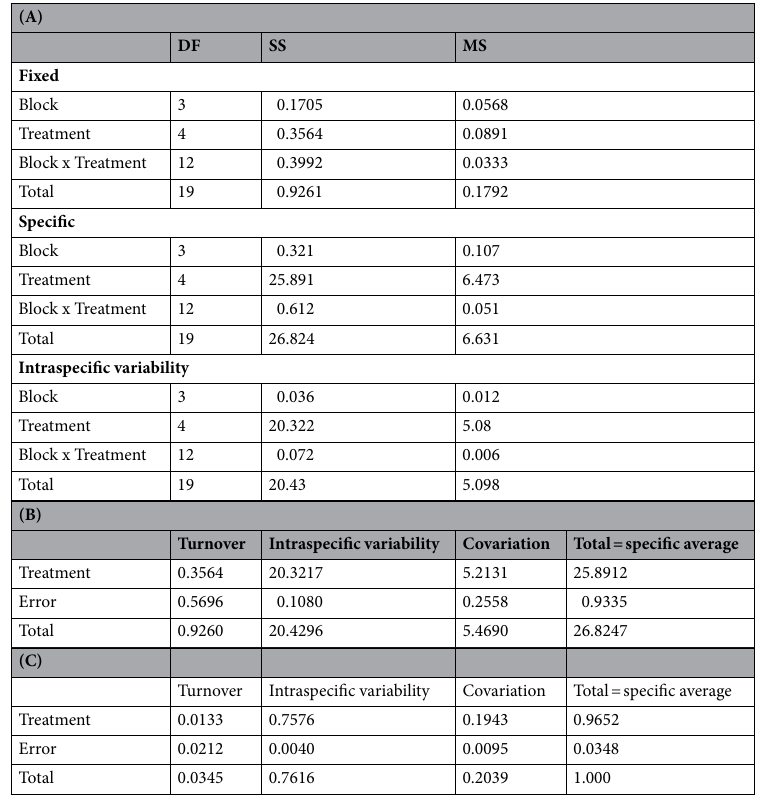
Table 3. Summary tables of the decomposition of total variability in plant height. (A) Fixed averages, specific averages and intraspecific variability effect analyzed separately. (B) Variability of individual component of height variation, and their parts explained by experimental treatments. Covariation is obtained by subtracting the first two columns from the last. C) Proportions of variability of individual components, and their parts explained by experimental treatments. SS (sum of squares) correspond to the amount of variability. Significant p -values ( p < 0.05) are in